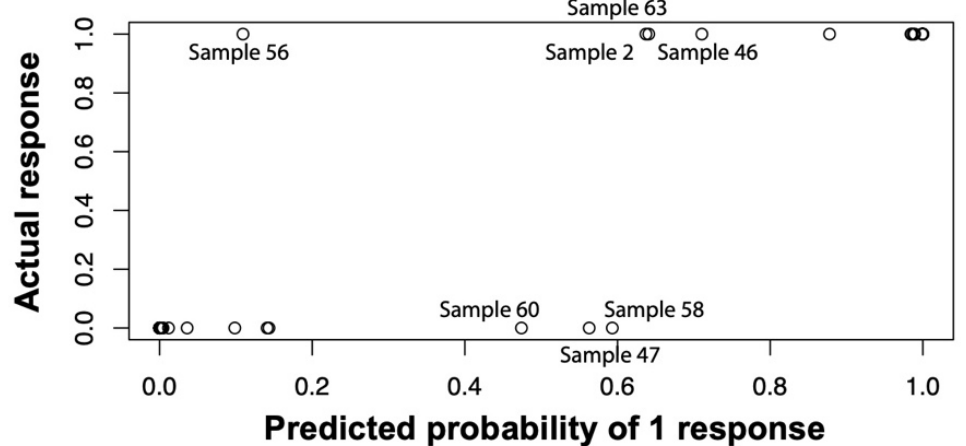
Figure 9. Comparison of predicted probability of infection by our logistic regression algorithm versus the actual response as defined by our modified Musculoskeletal Infection Society (MSIS) criteria. “0” indicates non-infected samples and “1” indicates infected samples. The “actual response” was based on our modified MSIS classification. Highlighted samples 2, 46, 47, 56, 58, and 60 were borderline cases whose clinical presentation was analyzed for the purpose of assignment to either the infected or non-infected group. Based on this clinical appearance, a cut-off of 0.5185 was chosen, which identified samples 47, 56, and 58 as ill-classified.